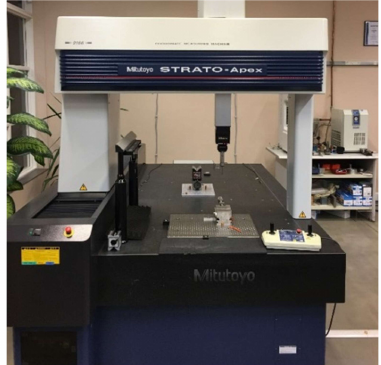
Figure 5. Coordinate Measuring Machines (CMM) Mitutoyo Strato—APEX 9166.